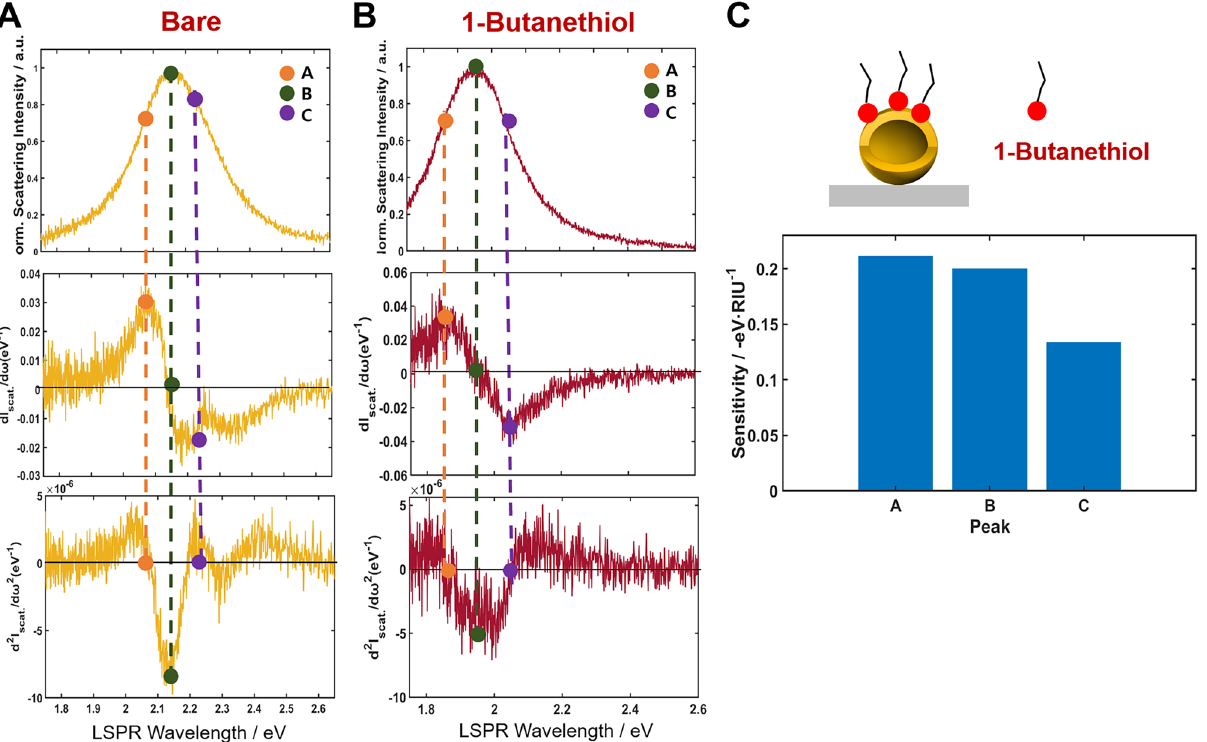
Figure 7. Inflection point method for the single-particle LSPR scattering sensing with HAuNSs in the presence of 1-butanethiol. ( A , B ) LSPR scattering efficiencies (first row) and their first (second row) and second (third row) order derivatives. ( C ) Sensitivities of peak shifts in A, B and C induced by the chemisorption of